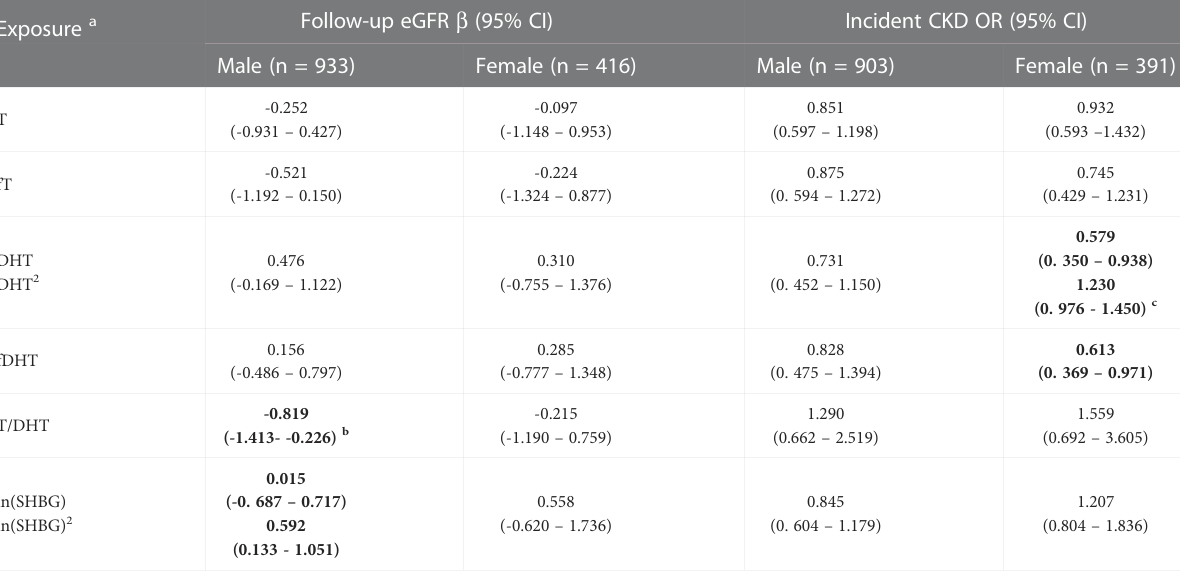
TABLE 3 Prospective associations between endogenous androgens and SHBG with follow-up eGFR and incident CKD. Exposure